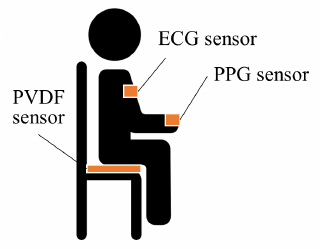
Figure 2. Overview of our experimental setup.